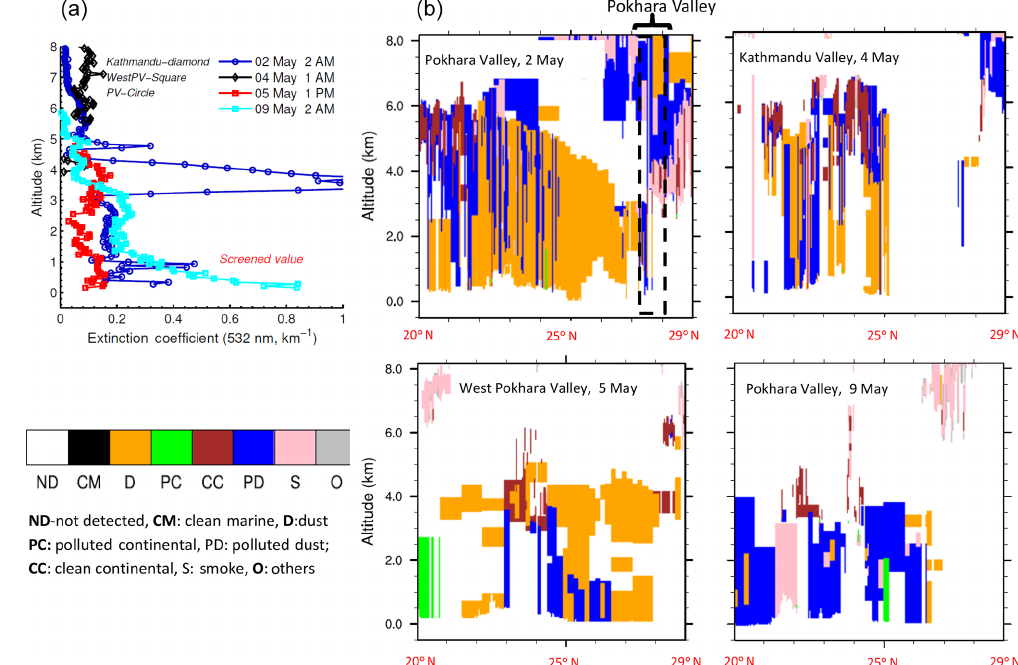
Figure 5. Aerosol extinction coefficient (at 532nm) vertical profile (a) and aerosol type classification based on the CALIPSO level 2 retrieval (b) . Only the CALIPSO overpass over the Pokhara Valley or nearby locations (such as the Kathmandu Valley region and the region to the west of the Pokhara Valley) is included. The extinction profile is averaged for the region 27–28.5 ◦ N latitude, which also includes the Pokhara Valley. The satellite overpass time is shown in Nepal Standard Time